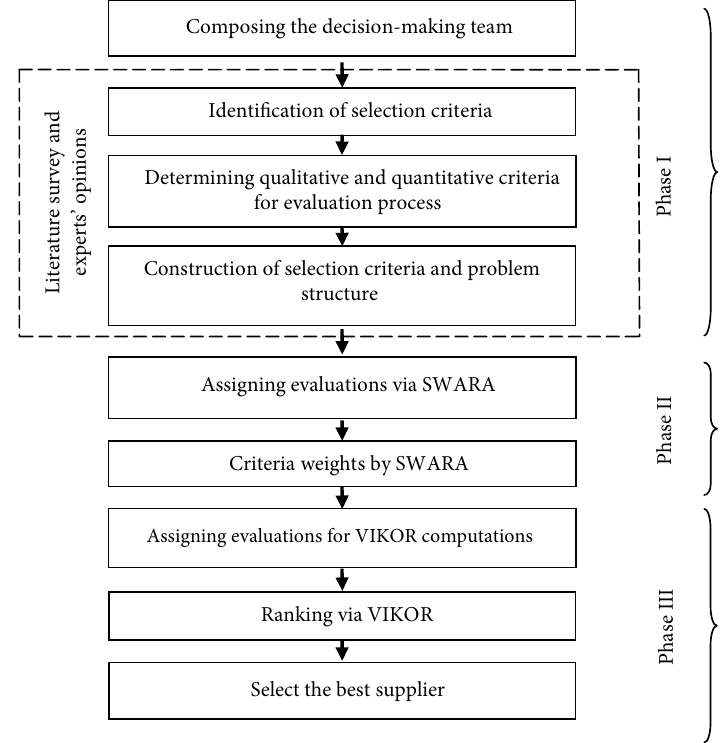
fig. 1. The evaluation